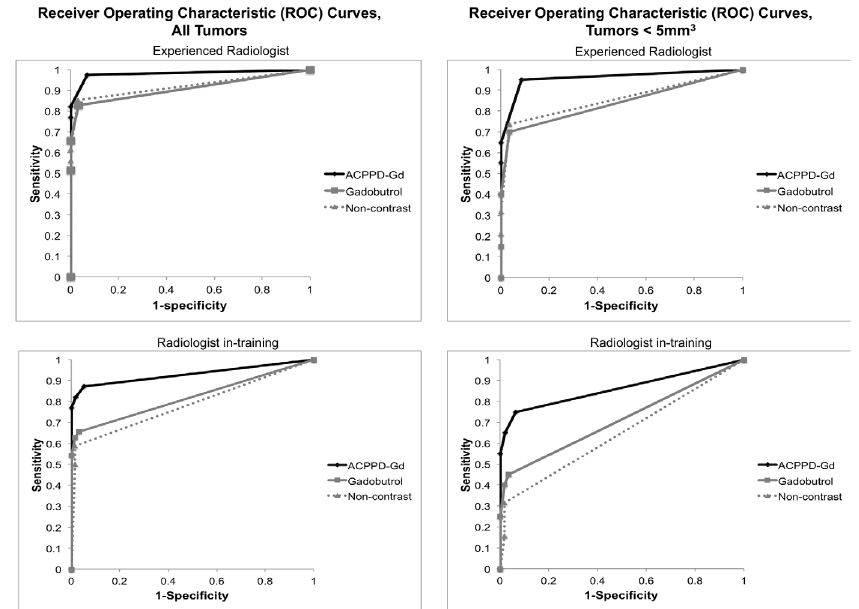
Fig 4. ROC curves. The ROC curves are plotted for the experienced (top row) and trainee (bottom row) for all 288 breasts (left column) that were normal (n = 181) or tumor bearing (107) and the breasts with small tumors ( < 5mm 3 ) (n = 58) and the associated normal breasts within the same animals (right column). Note that the AUC improved for both observers after ACPPD-Gd but the improvement was more significant for the trainee.